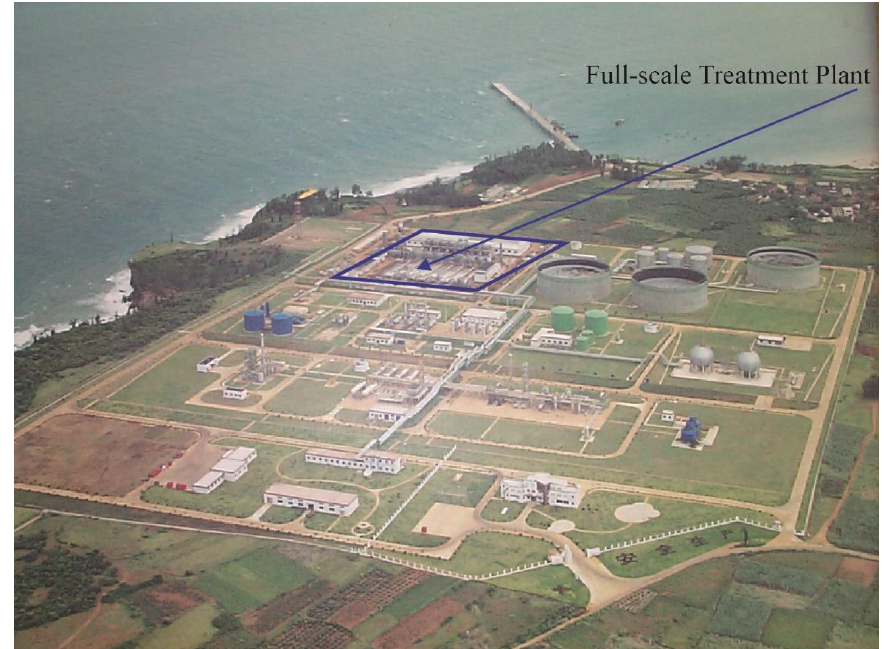
Figure 1. Location of high-salinity wastewater discharged from offshore oil rigs (WORS) treatment plant in China National Offshore Oil Corporation (CNOOC)